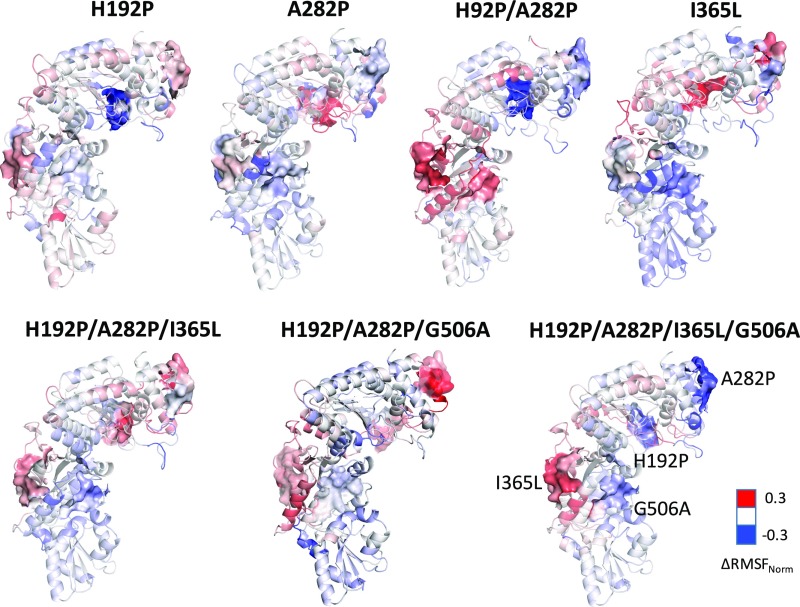
TK variants structures colored by normalized RMSF change with WT. TK variants structures and RMSF values were achieved from the average of last 10-ns MD simulation trajectory at 370 K. The residues within 5 Å around mutation sites were shown with surface. The mutation sites were only labeled on the structure of H192P/A282P/I365L/G506A.